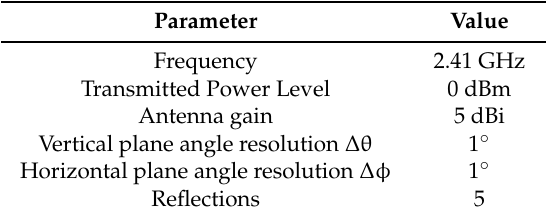
Table 2. Simulation parameters used in the 3D Ray Launching code.